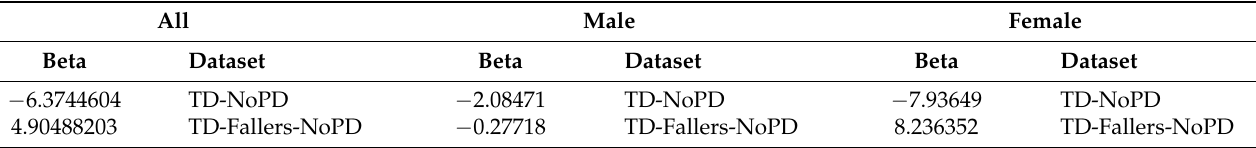
Table A12. Ensemble model coefficient for combining TD-NoPD and TD-Fallers-NoPD